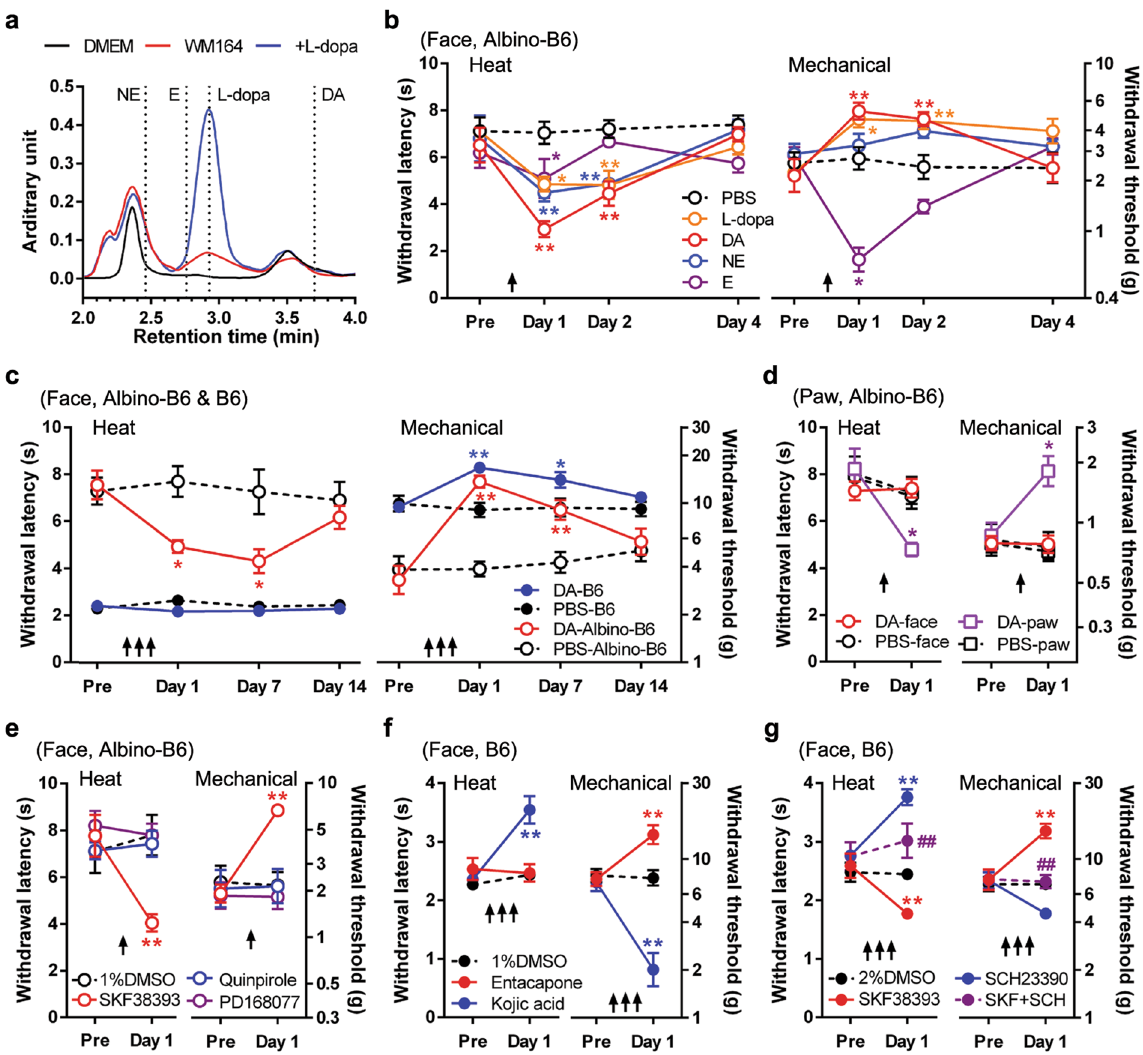
Figure 3. Pigmentation-dependent cutaneous sensations are mediated by skin dopaminergic signalling. All plots show mean ± s.e.m. Each animal experimental group, n = 5. Arrows indicate time of drug injection. ( a ) L-dopa secretion from melanoma cells. High-performance liquid chromatography of supernatant from human melanoma WM164 cells (red line). DMEM is the culture medium (black line). Dashed lines show peaks of norepinephrine (NE), epinephrine (E), L-dopa ( + L-dopa, blue line, at 500 μ M) and dopamine (DA). The experiment was replicated 5 times. ( b ) Withdrawal latency to radiant heat stimulation (heat) and threshold by von Frey-mechanical stimulation (mechanical) following injection of L-dopa, DA, NE, E (each 50 nmol in phosphate-buffered saline (PBS)) into the face of albino-B6 mice. * P < 0.05, ** P < 0.01, vs PBS, in Sidak’s post hoc test following two-way ANOVA test. ( c ) Effects of repetitive DA injection (3 times) on withdrawal latency to heat stimulation and mechanical withdrawal threshold in the face of B6 and albino-B6. In B6, a single dopamine injection did not show any effect on cutaneous sensations one day following the injection (data not shown). Repeated injections of dopamine had no effect on heat sensitivity on days 1 and 7 although it reduced mechanical sensitivity. * P < 0.05, ** P < 0.01, vs PBS, in Sidak’s post hoc test, following two-way ANOVA test. ( d ) Effects of DA injection into the face or hind paw on cutaneous sensitivities in the hind paw of albino-B6. ( e ) Effects of the D 1/5 agonist SKF38393, the D 2/3 agonist quinpirole, and the D 4 agonist PD168077 (15 nmol each) in the face of albino-B6. ( f ) Effects of entacapone (50 nmol, an inhibitor of dopamine degradation) and kojic acid (1.5 μ mol, an inhibitor of tyrosinase) in B6. ( g ) Effects of SKF38393 (15 nmol) and/or the D 1/5 antagonist SCH23390 (50 nmol) in B6. * P < 0.05, ** P < 0.01, vs each control (PBS or 1–2% dimethyl sulfoxide (DMSO)) and ## P < 0.01, vs SKF38393, in two-way ANOVA